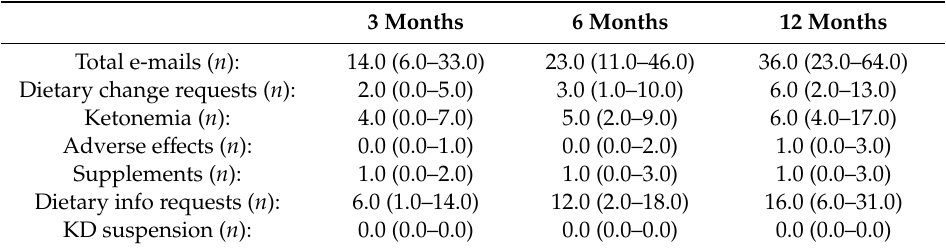
Table 2. E-mail monitoring in total